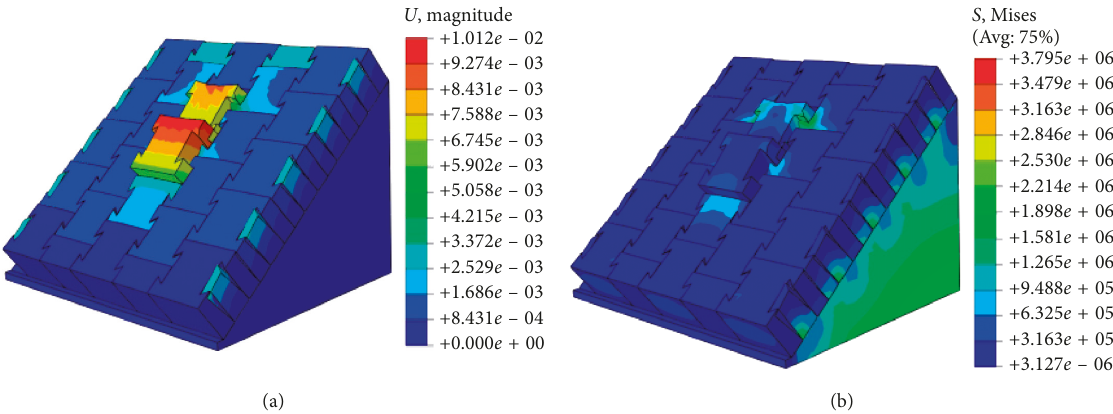
Figure 15: Cloud diagram of numerical simulation results of traditional block 1 revetment. (a) Equivalent displacement nephogram. (b) Equivalent stress nephogram.